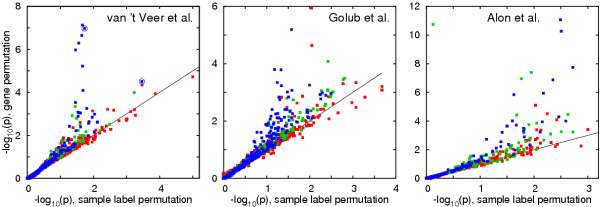
Comparing null hypotheses. Comparison of p-values obtained by sample label permutations and gene permutations, using the data set of van 't Veer et al. [13] (left), Golub et al. [11] (middle), and Alon et al. [20] (right). Sample label permutation results were obtained with 100.000 permutations for the van 't Veer et al. data set and with 10.000 permutations for the other data sets. Gene permutation results were calculated as described in Methods. Red, green and blue colours represent categories with 1 to 5, 6 to 20, and over 20 genes, respectively. Encircled boxes in the left figure represent the categories "M phase" and "carboxylic acid metabolism", which are further discussed in the text.